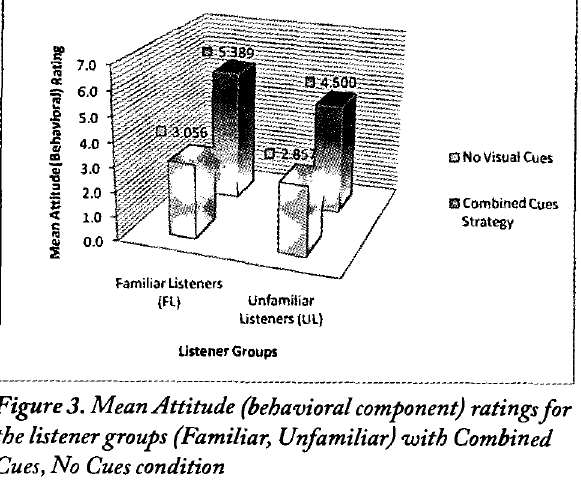
Figure 3. Mean Attitude (behavioral component) ratings for the listener groups (Familiar, Unfamiliar) with Combined Cues, No Cues condition vious attitude component results, the behavioural attitude results show a slight difference between the familiar lis­ tener (Combined Cues: M=5.38 SD=1.47; No Cues: M=3.056 SD=1.52) and unfamiliar listener groups (Combined Cues: M=4.5 SD=1.55; No Cues:M=2.85